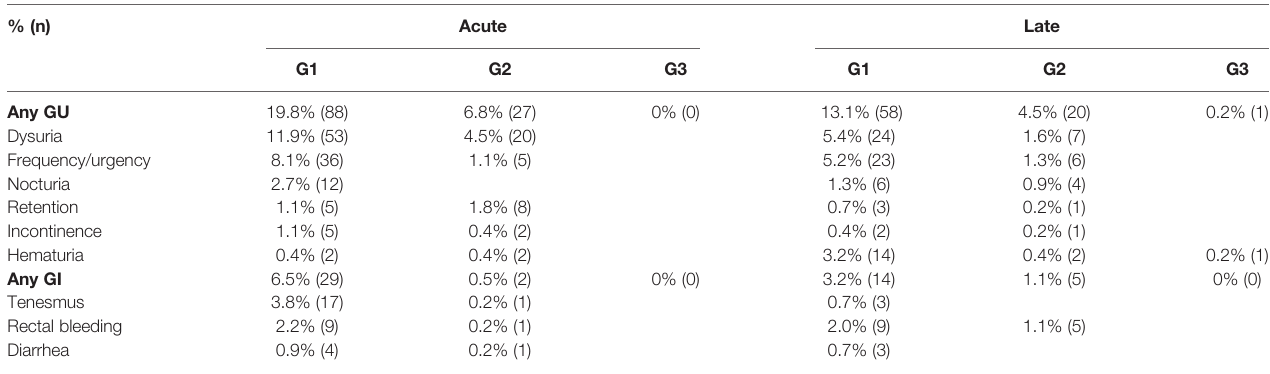
TABLE 3 | Acute and late